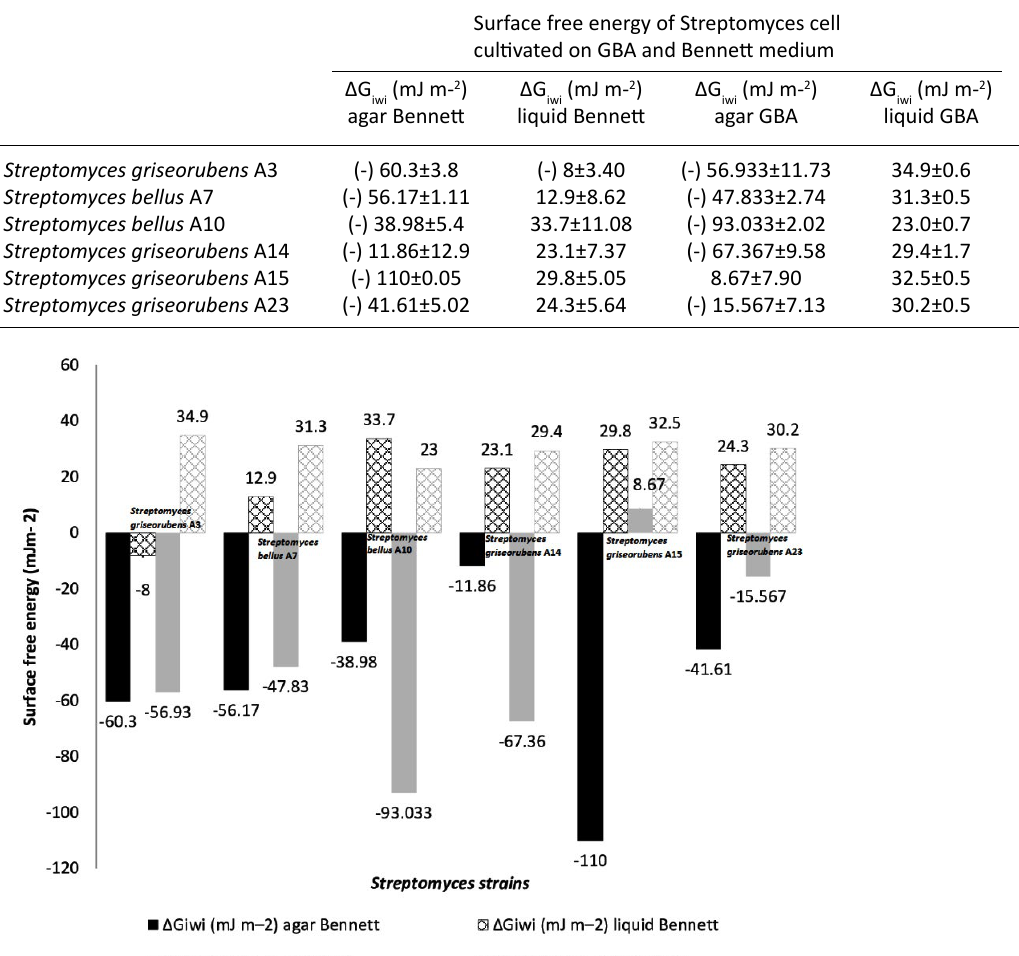
Table 5. Surface free enegy of Six Streptomyces strains (in mJ m- 2 ),grown in Bennett liquid, agar Bennett, GBA liquid, and agar GBA